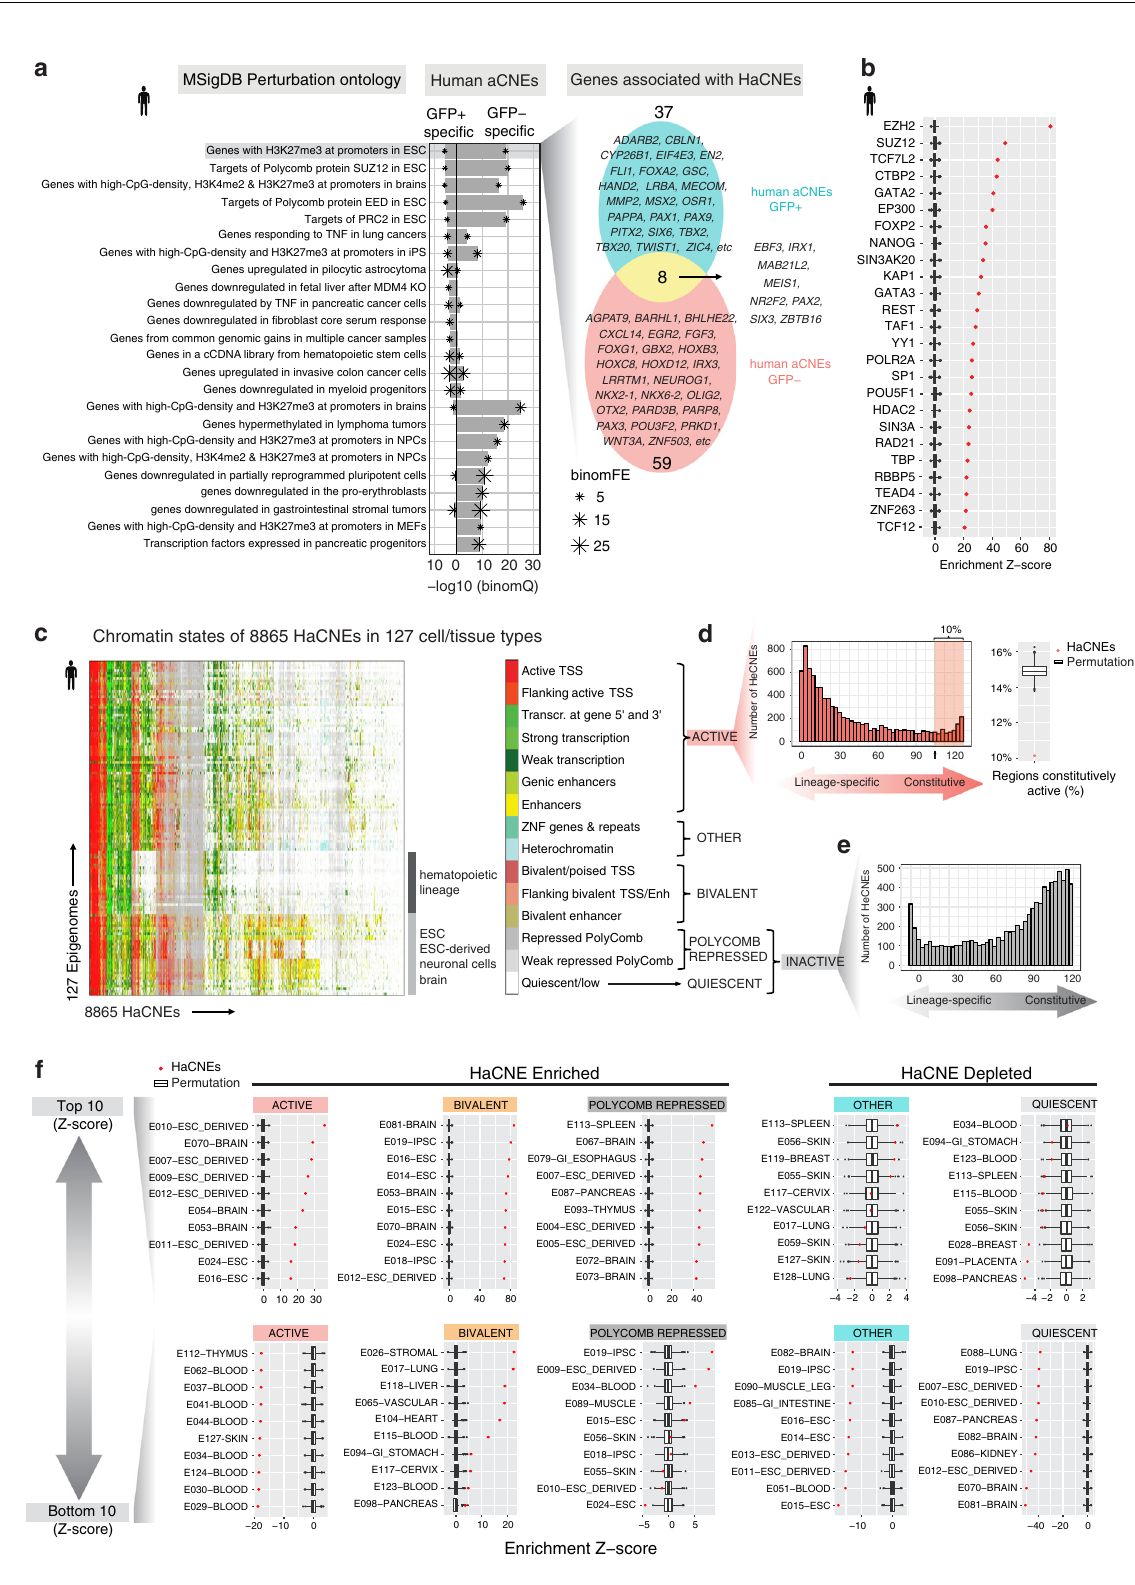
(Fig. 5c and Supplementary Fig. 8). Only 10% (899/8865) of the aCNEs showed constitutive activity (Active in >80% the tissues/ cell types) (Fig. 5d). Supporting this observation, aCNEs were depleted for regions of constitutive activity compared to bulk open chromatin regions (ENCODE3 human DNase I hypersen- sitivity site Master list, P = 0.001, permutation test; Fig. 5d). NATURE COMMUNICATIONS| (2018) 9:4977 |DOI: